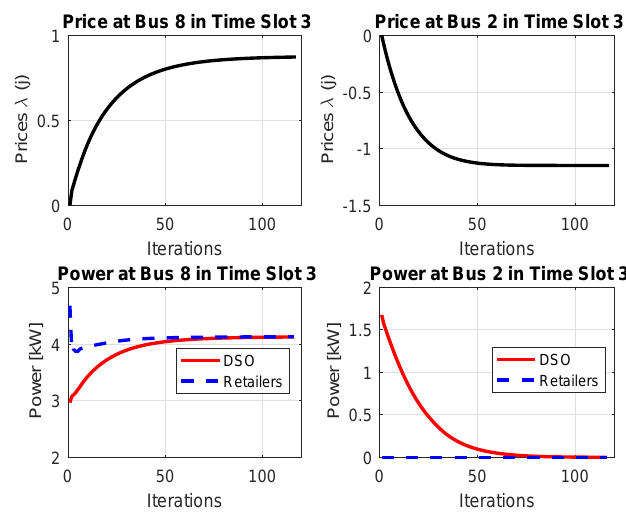
Figure 7. Development at bus 8 and bus 2, where congestion price updating method of (6) is used.